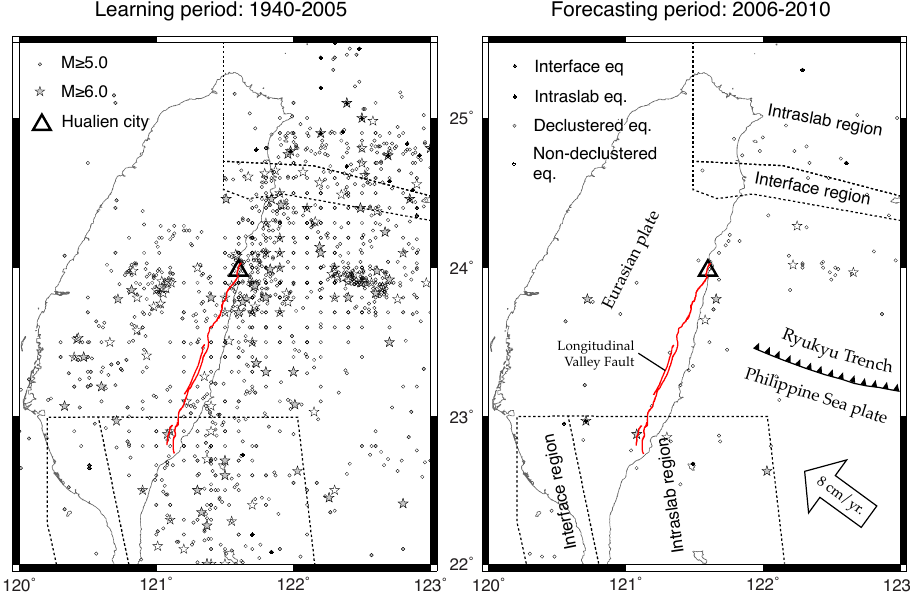
Fig. 1. The seismicity during the following: (a) the learning period (1940–2005), and (b) the forecasting period (2006–2010). The declustering and non-declustering earthquakes are shown with light gray and transparent colors, respectively. Earthquakes with M L ≥ 5.0 and M L ≥ 6.0 are shown with circle and star shapes, respectively. Red lines represent the Longitudinal Valley fault, the boundary between the Eurasian and Philippine Sea plates. Dashed lines represent the shapes of the subduction zones. The earthquake parameters are determined by the Central Weather Bureau Seismic Network